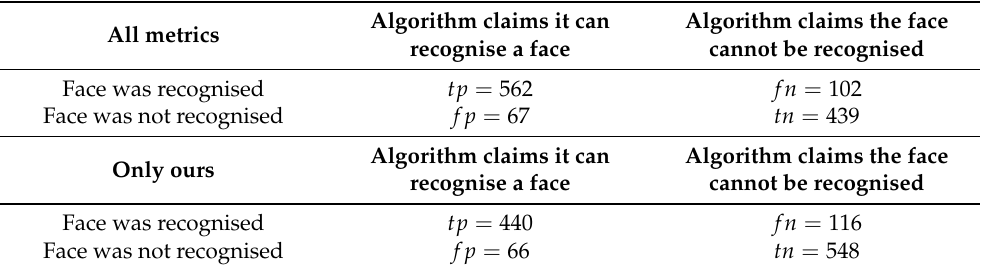
Table 6. Detailed results (true positives— t p , false positives— f p , true negatives— t n , and false negatives— f n ) we receive for face